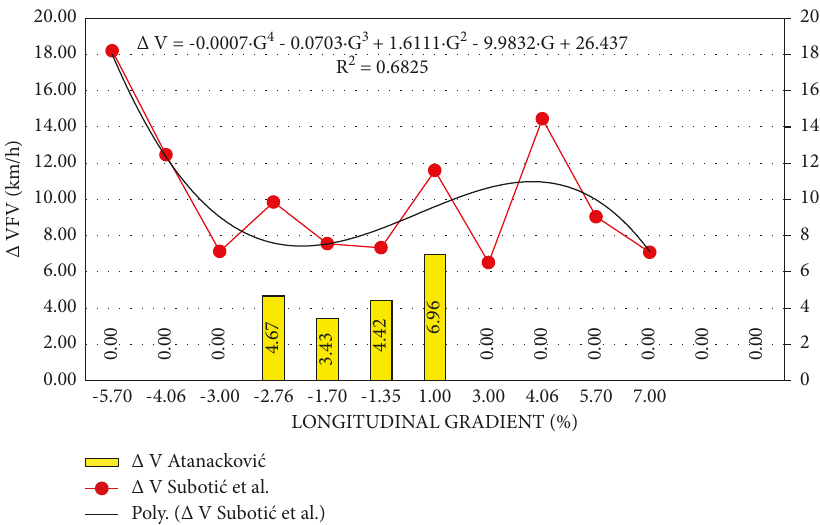
Figure 7: Comparative overview of Δ V for freight vehicles in Serbia ( Δ V Atanackovi´c) and BiH ( Δ V Suboti´c et